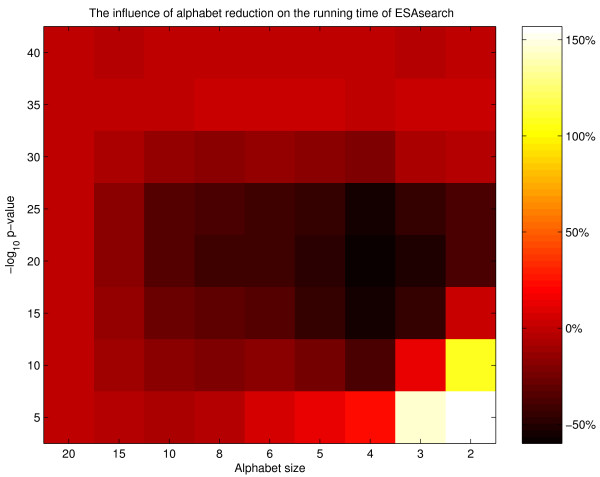
Effect of alphabet reduction on the running time of ESAsearch. Experiment 6: Relative deviations of running time of ESAsearch when using reduced alphabets at different levels of stringency. We measured the relative percentage deviation with respect to the running time when using the standard 20 letter amino acid alphabet (= 0%). We searched with 11,411 PSSMs from the PRINTS database (Rel. 38) in the RCSB Protein Data Bank (PDB) with a total sequence length of 4.3 MB. In this example, the maximum performance improvement is achieved for an alphabet of size 4 and a p-value cutoff of π = 10-20.